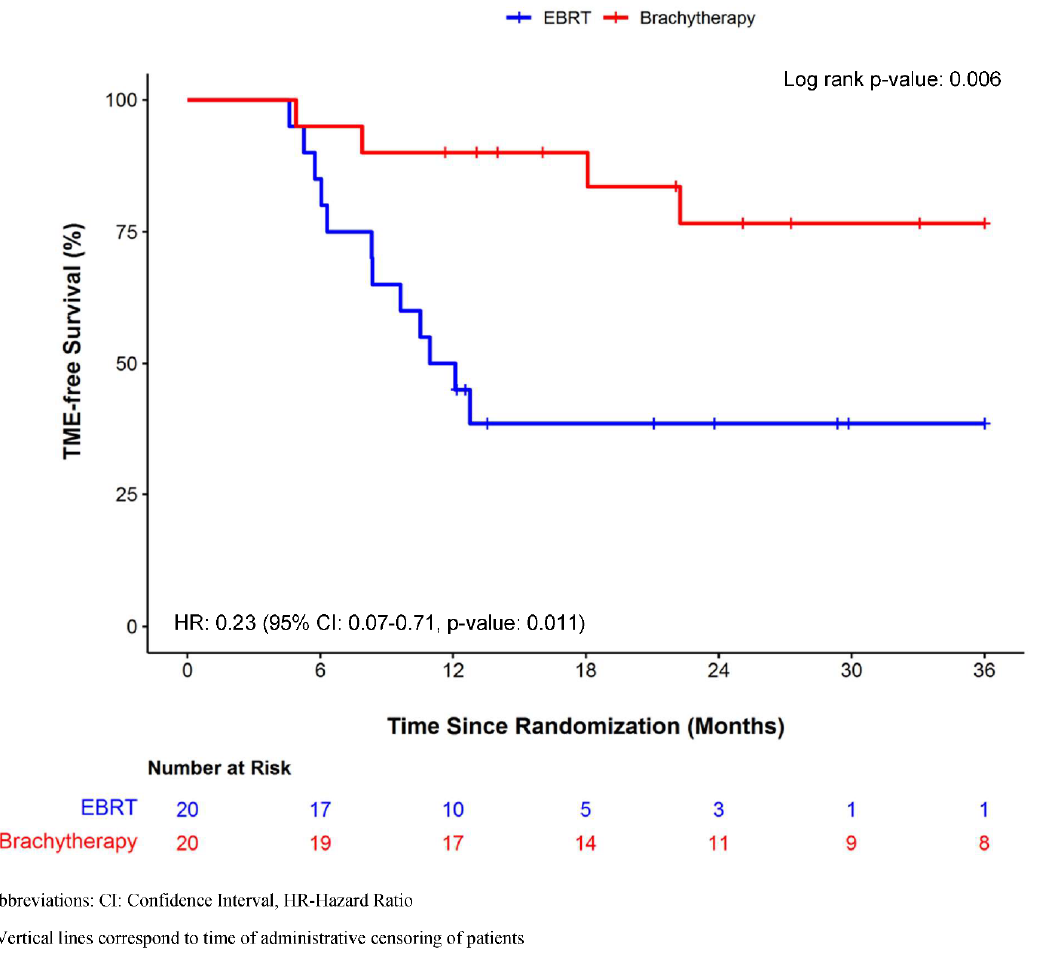
Figure 2. TME-free Survival probability when comparing IGAEBT versus EBRT in the intention to treat population. Table 4. Hazard ratio and 95% confidence interval of composite outcome (TME or death) when comparing IGAEBT versus EBRT arms in the intention to treat